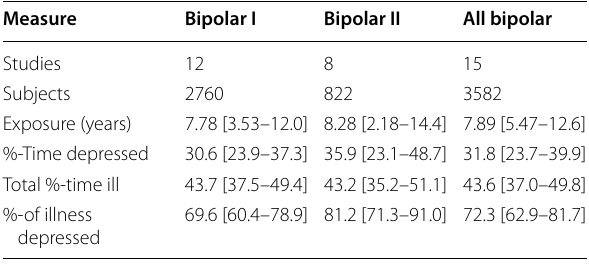
Data are means with 95% confidence intervals [CI]. Depression includes major episodes plus